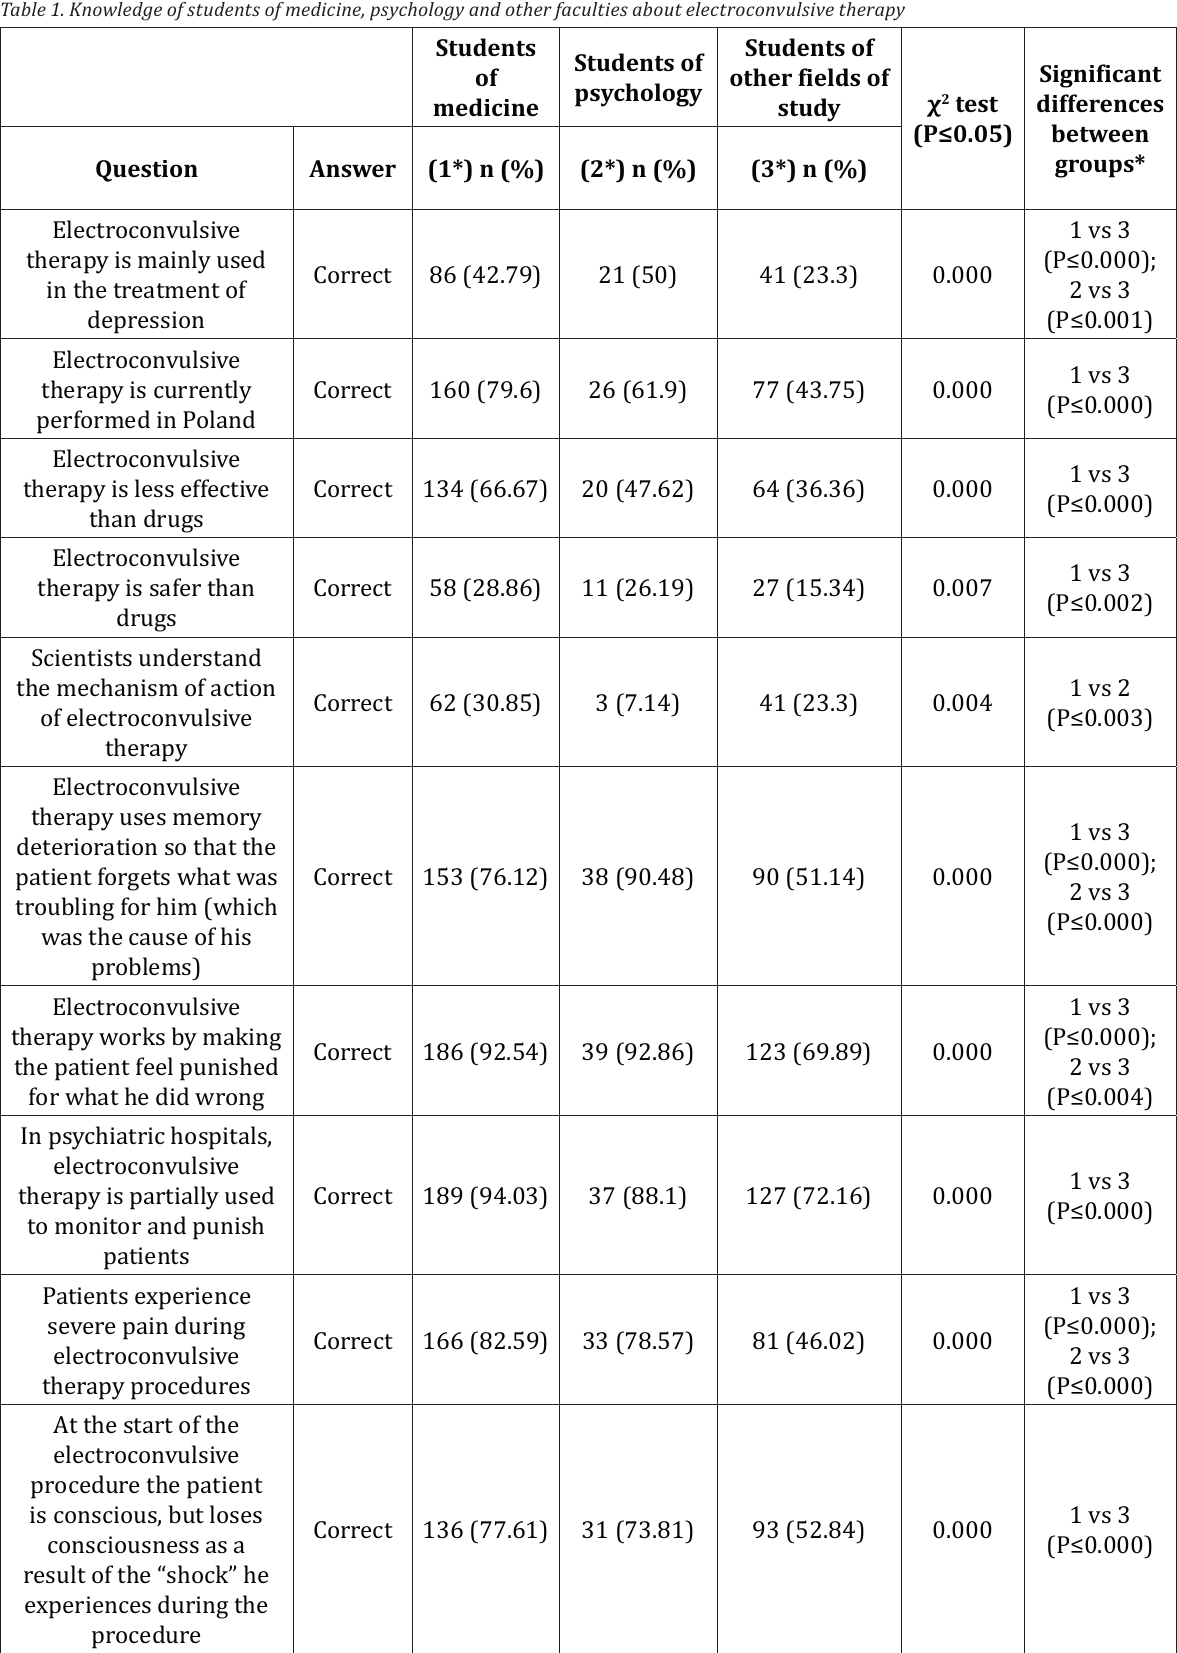
Table 1. Knowledge of students of medicine, psychology and other faculties about electroconvulsive therapy